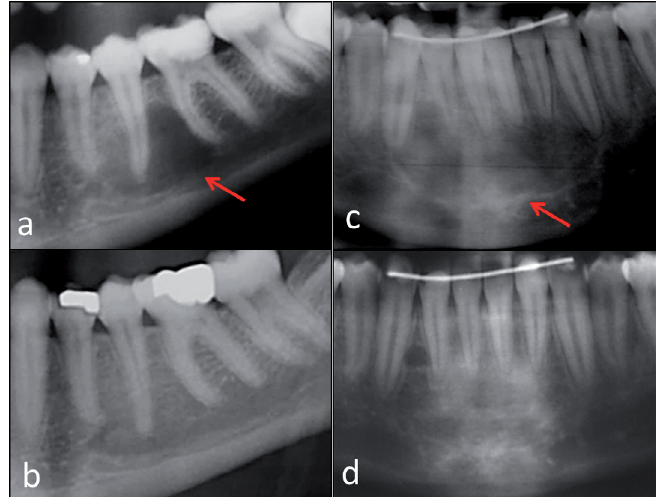
Figure 2- Radiographs showing spontaneous resolution of idiopathic bone cavity (IBC). a: A 15-year old female displaying an unilocular, well-defined radiolucency in the posterior mandible (red arrow); b: Final panoramic radiograph of the same patient after eight years of follow-up, showing complete resolution of the lesion; c: A 15-year-old female displaying an unilocular, well-defined radiolucency with scalloped margin surrounding the teeth apex in the anterior mandible (red arrow); d: After eight years of follow-up, we observed regression of the